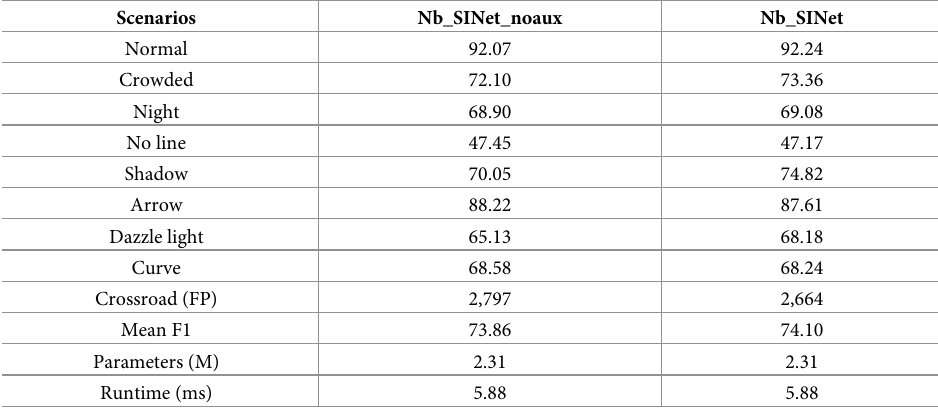
Table 4. Performance comparison of auxiliary trainer ablation experiments.